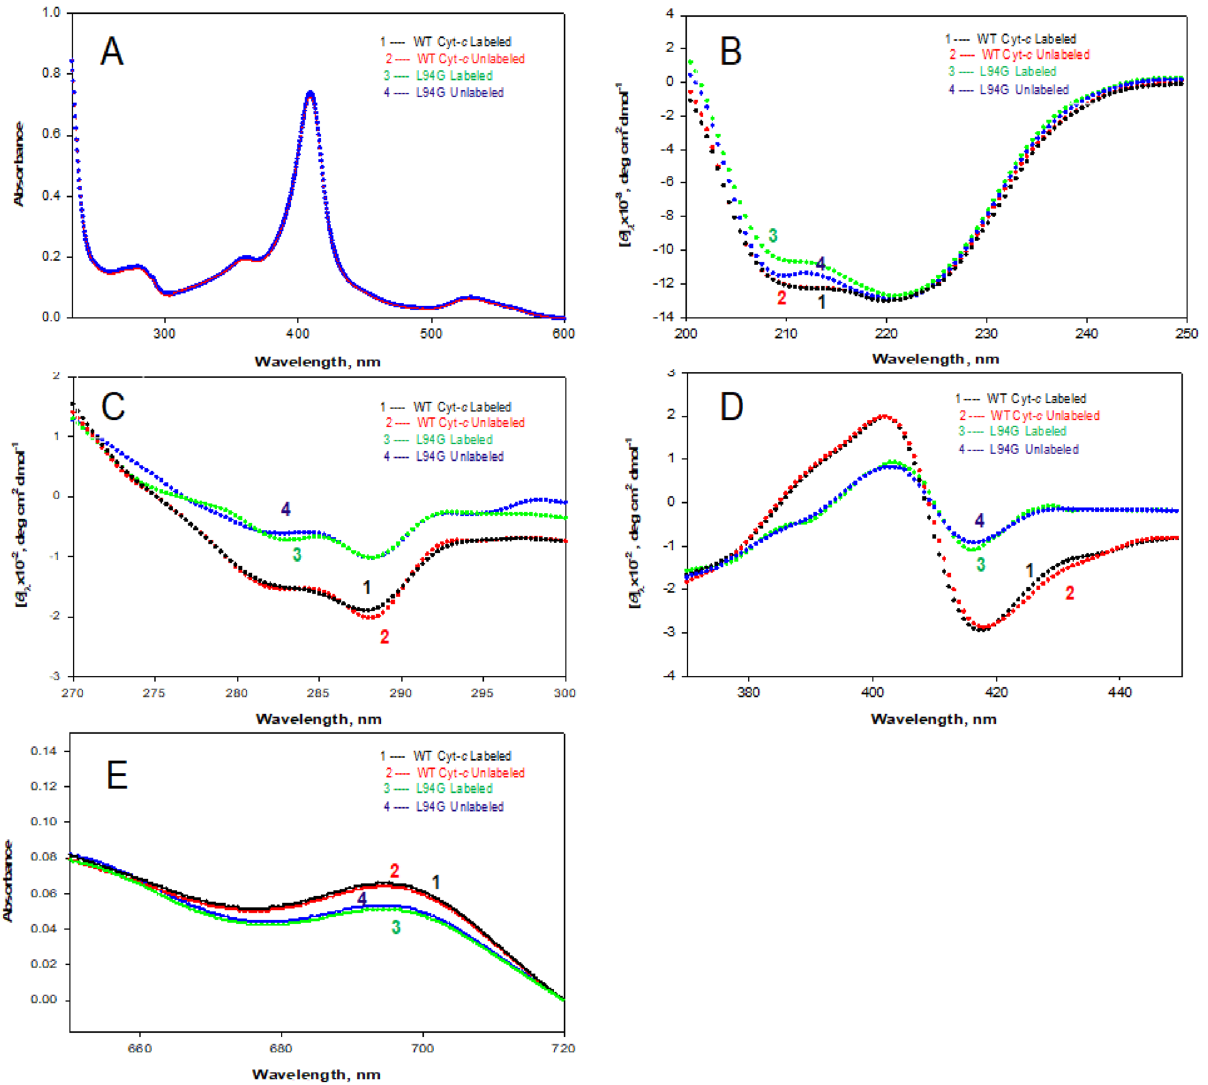
Figure 2. Spectroscopic characterization of WT cyt c and its L94G mutant. Protein concentration used for CD measurements was in the range of 14–18 μM. Protein concentration was in the range 6–8 μM and 75–80 μM for absorption measurements in the wavelength range of 600–230 nm and 720 –650 nm, respectively. (A) UV– Vis absorption spectra in the wavelength range 600–230 nm. (B) Far-UV CD Spectra in the wavelength range 250–200 nm. (C) Near-UV CD Spectra in the wavelength range 300–270 nm. (D) Soret CD Spectra in the wavelength range 450–370 nm. (E) Absorption spectra in the wavelength range 720–650 nm. All spectra were taken in the native buffer (30 mM cacodylate containing 100 mM NaCl, pH 6.0) at 25 ± 0.1